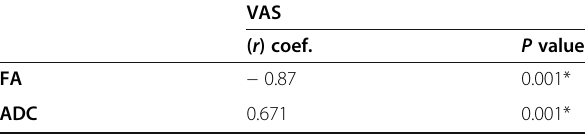
Table 3 Correlation between DTI parameters and VAS